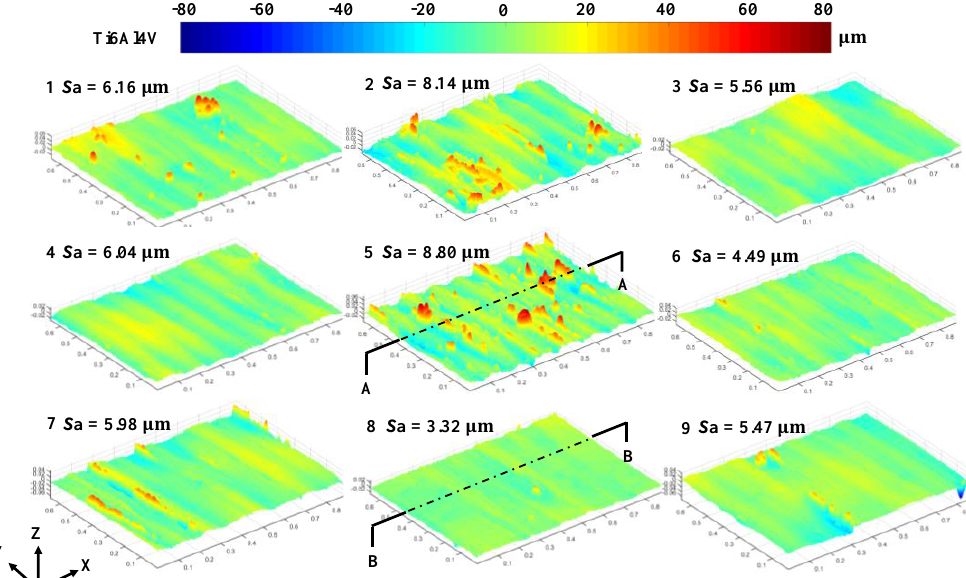
Figure 4. Three-dimensional contours of the Ti6Al4V sample after laser polishing.